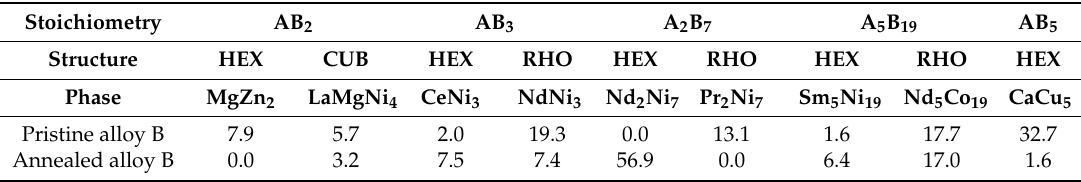
Table 2. Energy-dispersive spectroscopy (EDS) results from selected spots in Figure 2. All numbers are percentages.